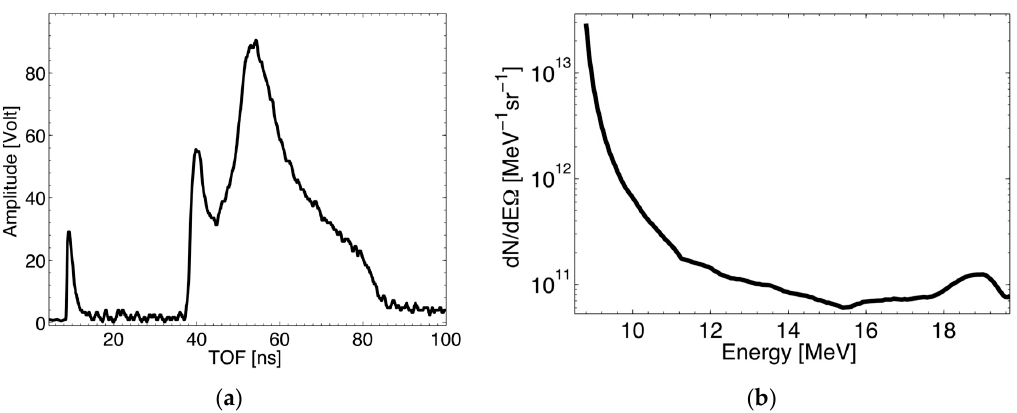
Figure 5. ( a ) Time-of-flight (TOF) signal acquired with a 140 μ m single crystal diamond detector at 2.35 m downstream the target; ( b ) Proton energy spectrum extracted from the TOF signal is shown on the